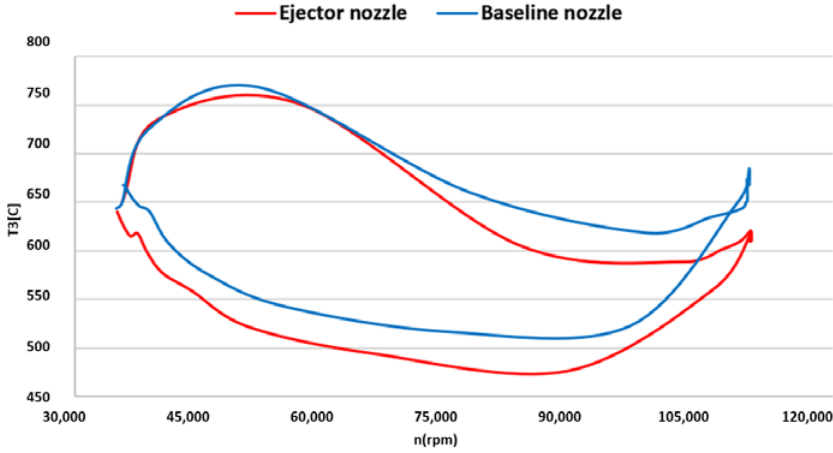
Figure 22. Temperature variation in front of the turbine during acceleration and sudden acceleration.